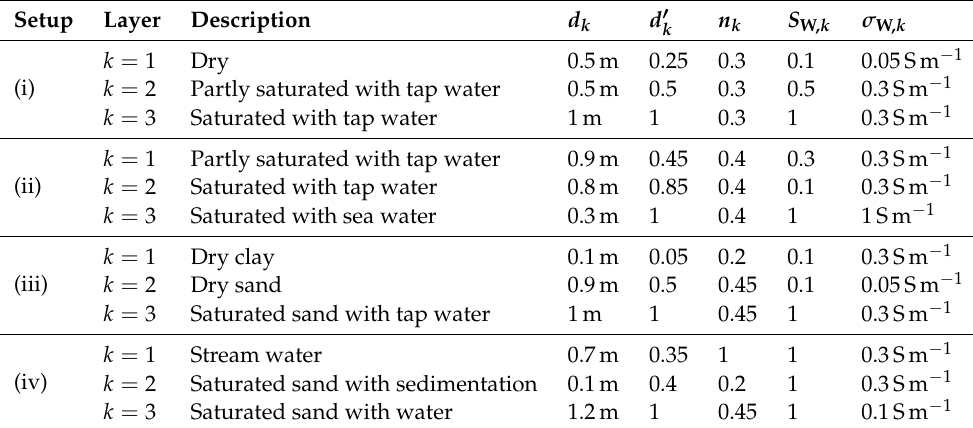
Table 2. Experimental setups of the synthetic